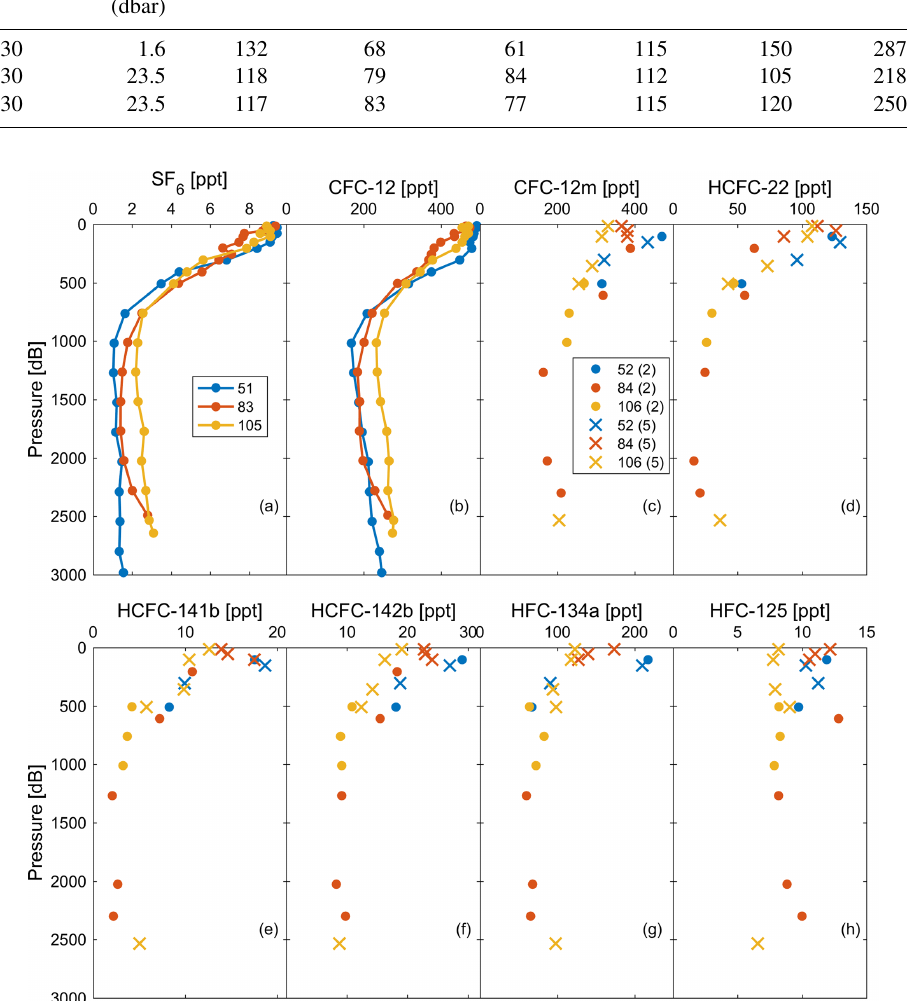
Figure 9. Observations of (a) SF 6 and (b) CFC-12 in profiles 51, 83, and 105 measured by the PT-GC-ECD; (c) CFC-12 (marked as CFC-12m), (d) HCFC-22, (e) HCFC-141b, (f) HCFC-142b, (g) HFC-134a, and (h) HFC-125 in profiles 52, 84, and 106 measured by the Medusa–Aqua system. For an explanation of the values (2 and 5) and symbols (dots and crosses), refer to Fig.